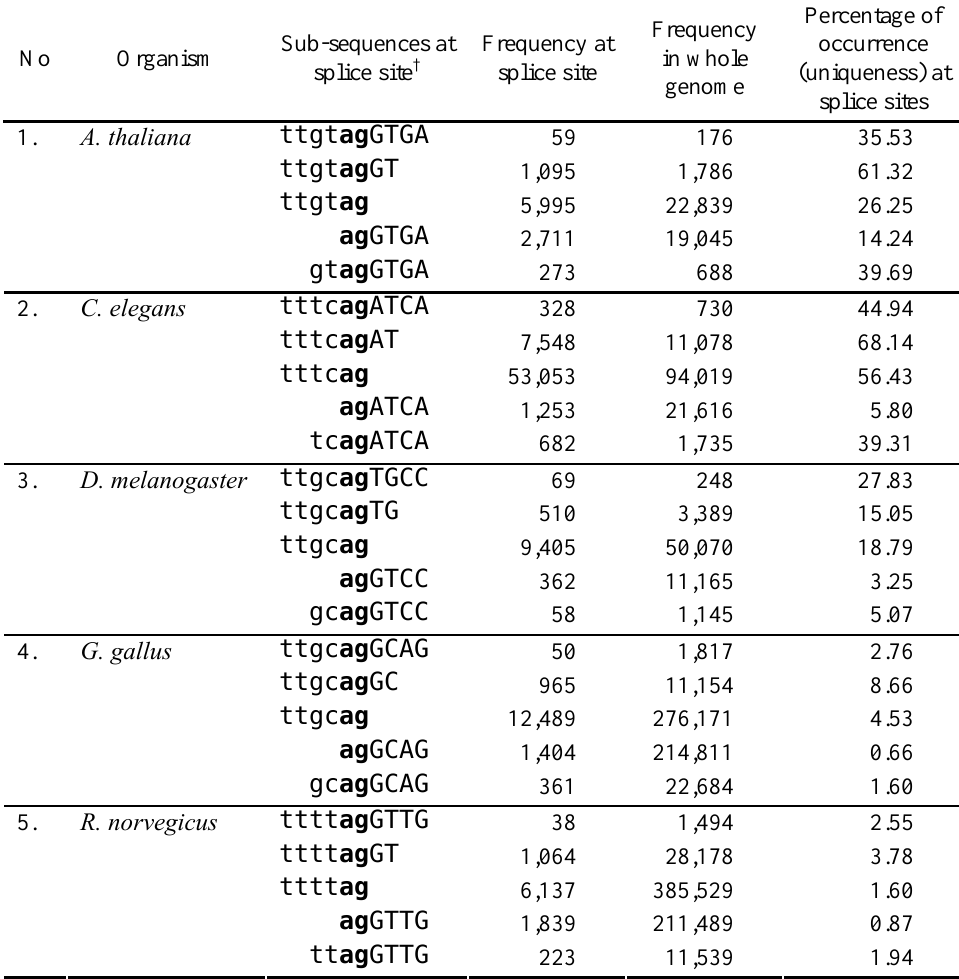
Table 6b. Percentage of occurrence (uniqueness) of different sub-sequences (with medium frequency) of size ten at the acceptor splice site region and the whole genome of the